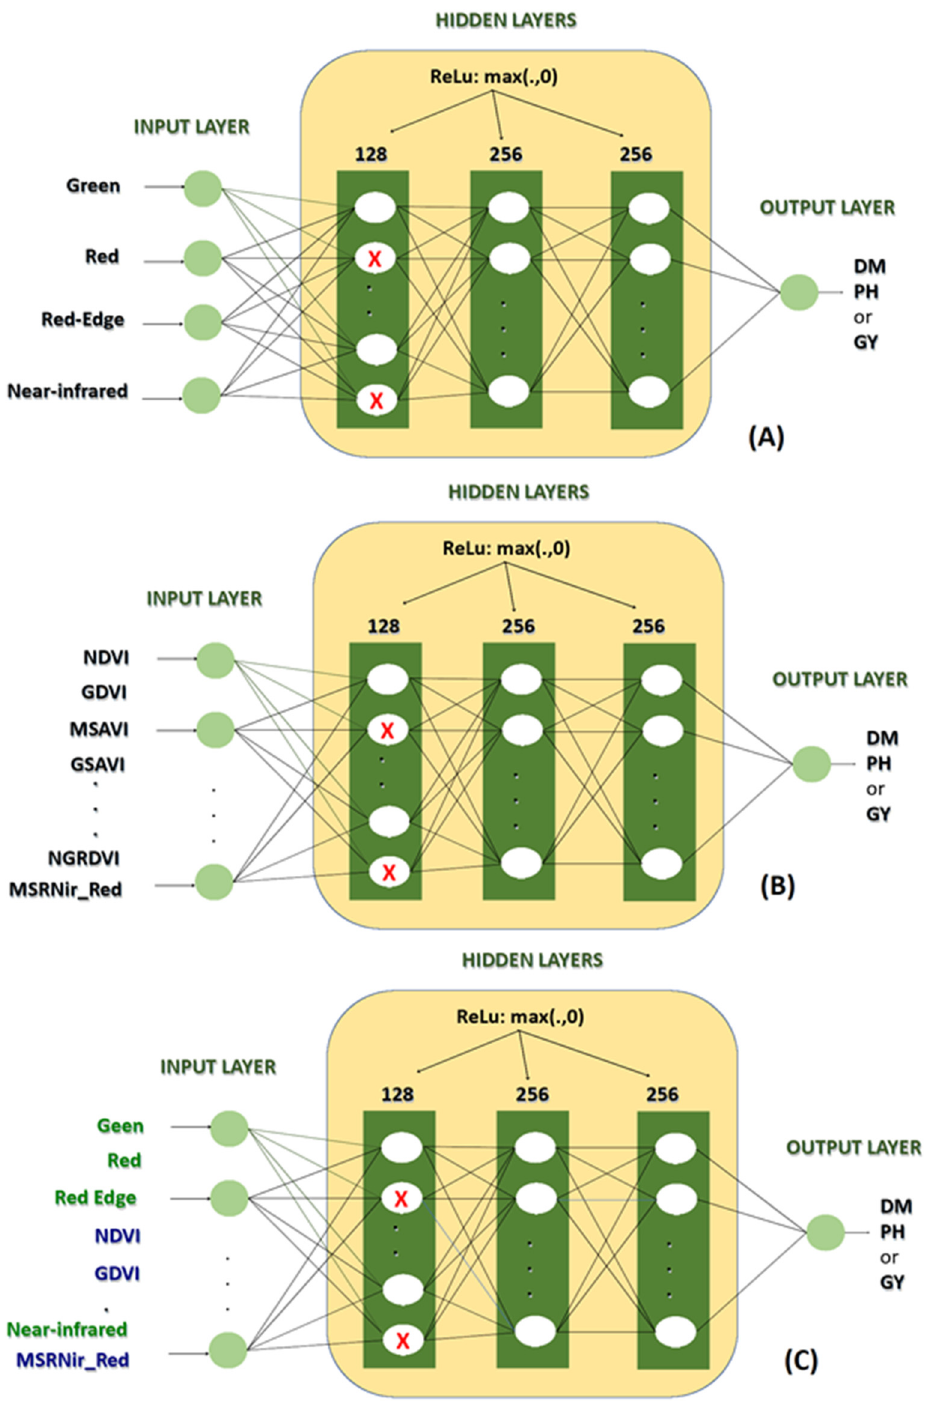
Figure 2. Architecture of the three deep learning networks (DL) proposed in the study. ( A ) corre- sponds to the network using the spectral bands of the images as input layer; ( B ) corresponds to the network using the vegetation indices as input layer; ( C ) corresponds to the network using the spec- tral bands and vegetation indices as input layer.